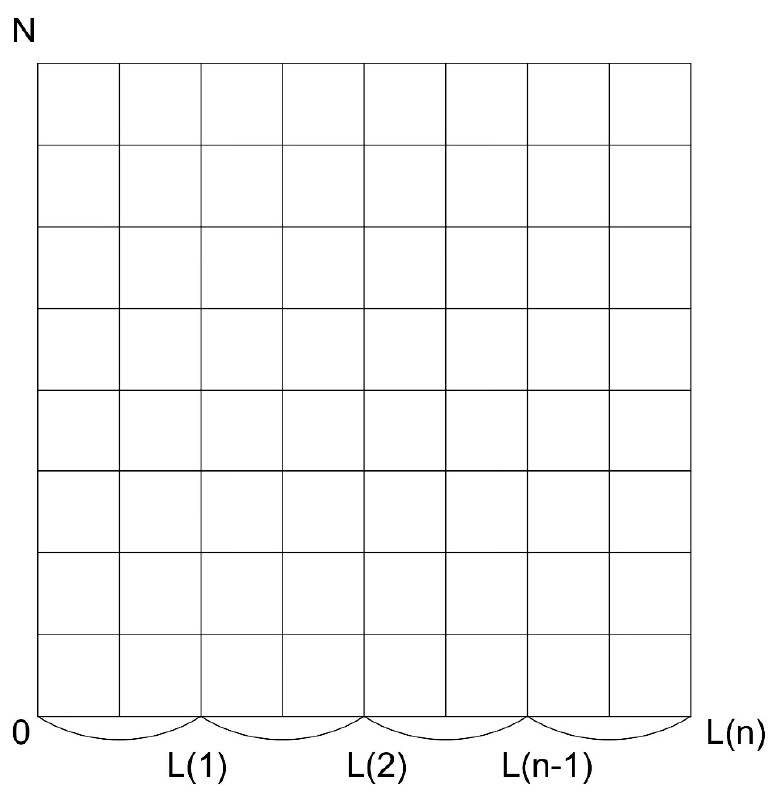
Figure 2. Scheme of parallelization of the calculation along the L axis.